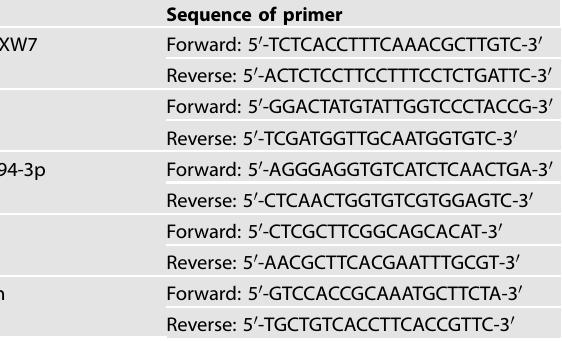
Table 1. The sequences for